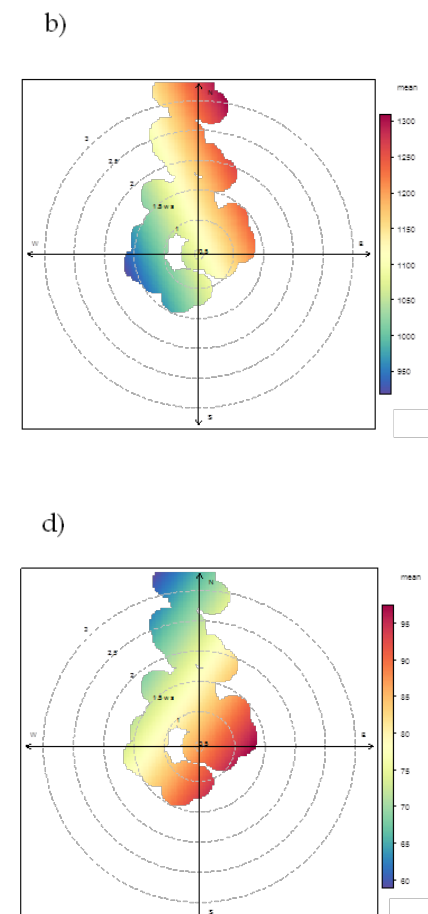
Figure 6. Percentage contribution of factors on Pb concentrations at the receptor sites.